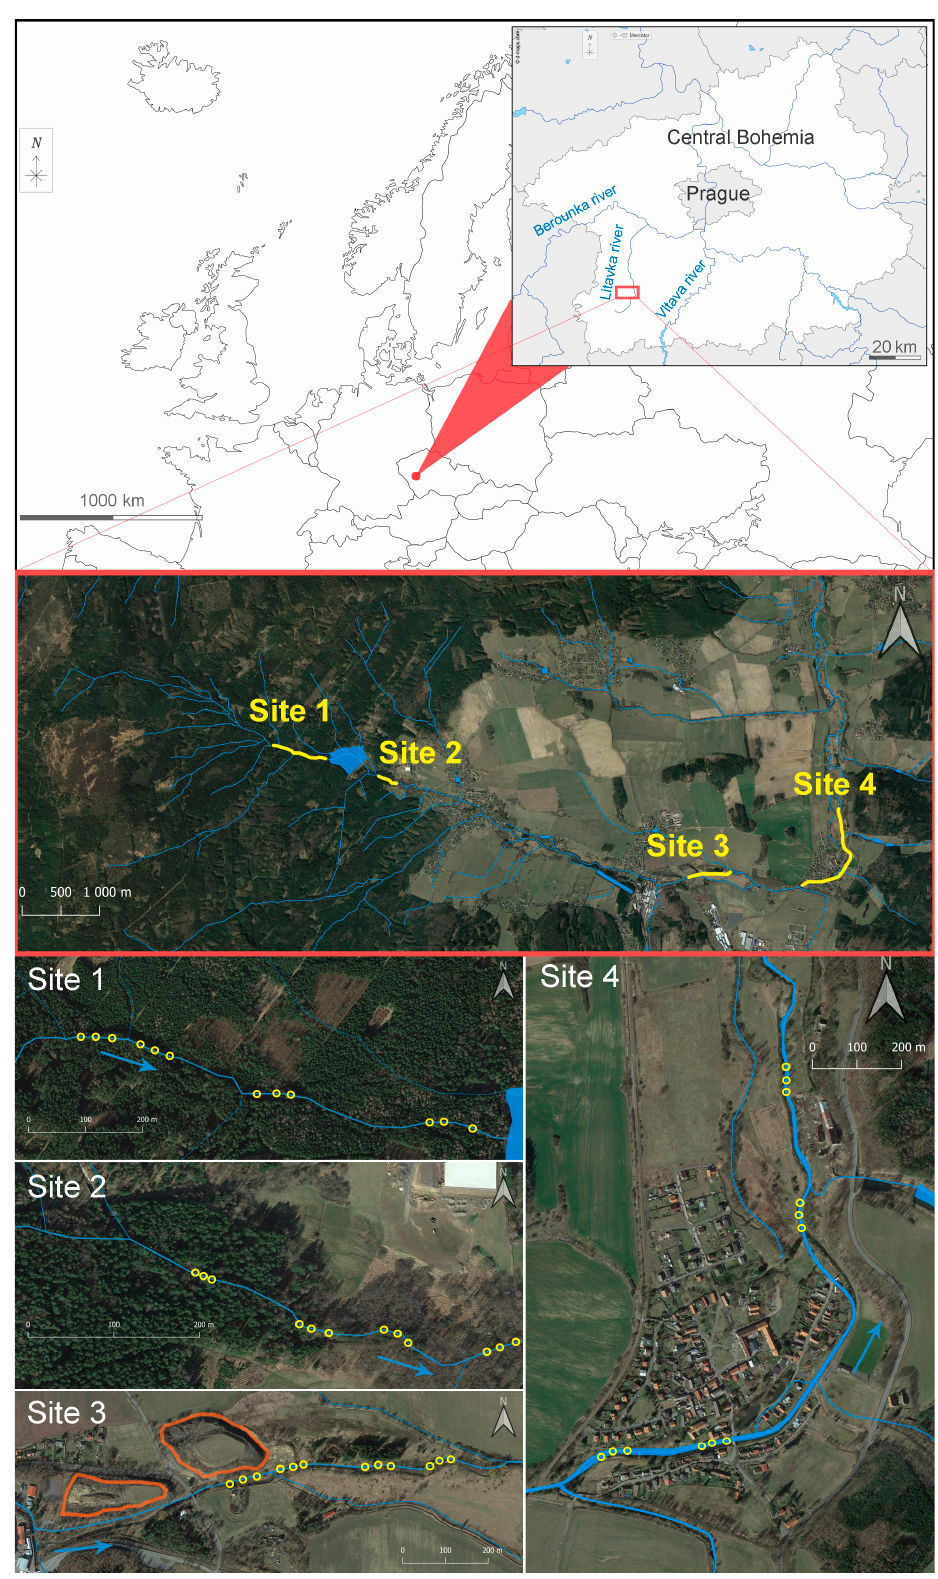
Figure 1. Map of the study area. The yellow circles indicate the sampling points. A set of three sampling points represents a whole plot. The contoured orange-coloured areas in the close-up view of Site 3 (lower left-hand corner) are slag heaps and waste material generated by the smelting industry. The river’s flow direction is indicated by blue arrows.